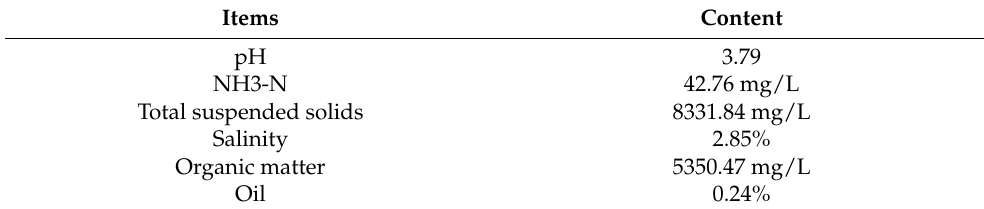
Table 2. Basic physical and chemical properties of